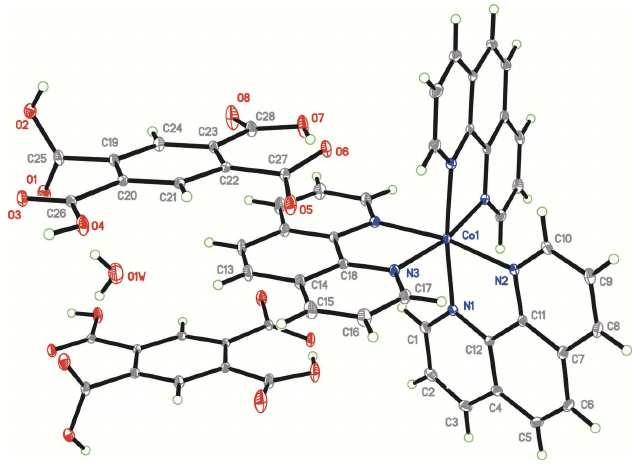
Figure 1 Expanded asymmetric unit of the title salt, showing the atom-numbering scheme, with displacement ellipsoids drawn at the 30% probability level. Unlabelled atoms are generated by the symmetry operation (cid:4) x + 1, y , (cid:4) z + 1 2